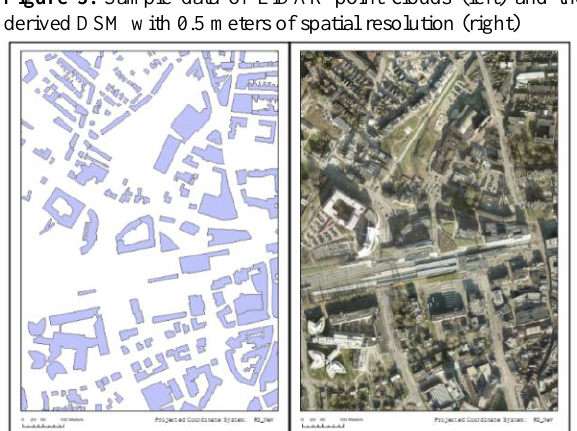
Figure 4. Sample data of the building footprints (left) and an aerial image of the represented area